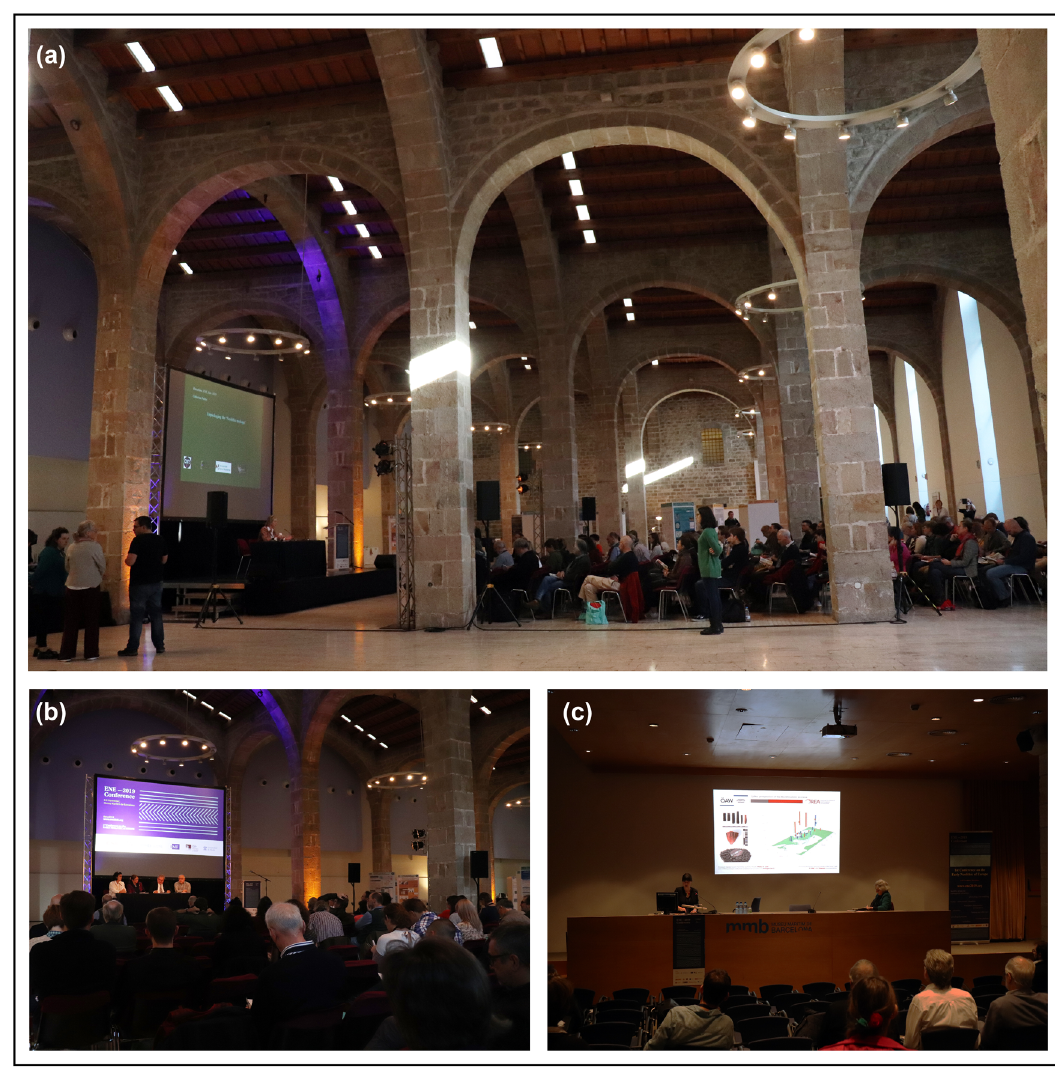
Figure 2: Inauguration of the meeting by the authorities ( b ) , keynote lecture of the “ Neolithic spread and supraregional interactions ” session by Catherine Perlès ( a ) and oral presentation by Bogdana Milic in the parallel session “ Technological processes ” chaired by A. van Gijn ( c )